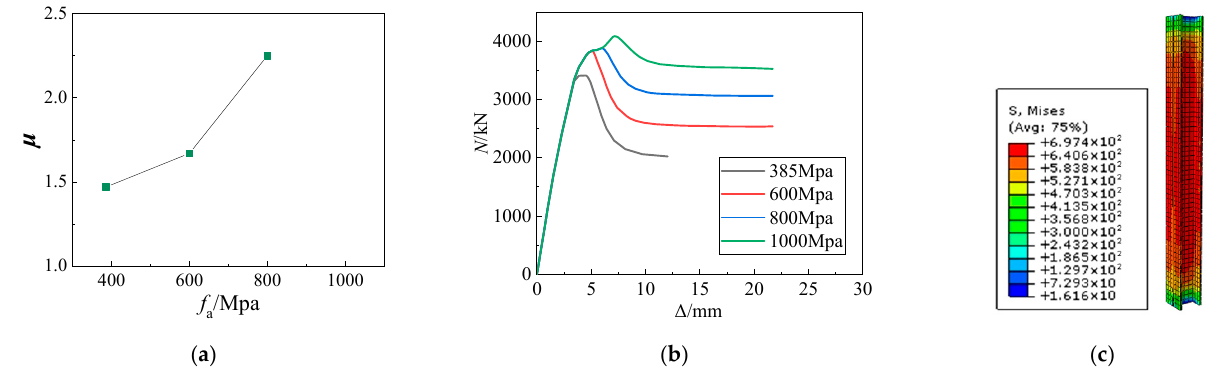
Figure 15. The simulation results at different steel strengths: ( a ) the ductility coefficient at various steel strengths; ( b ) the N – Δ curves at different steel strengths; ( c ) the steel stress nephogram of specimen S10.